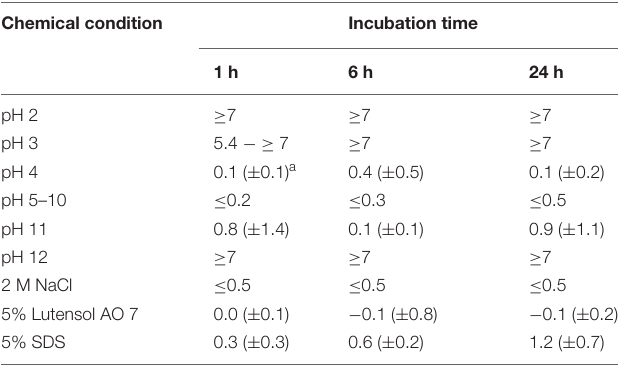
TABLE 1 | Reduction of infectivity of P100 after incubation in TSB adjusted to different pH values, containing NaCl or detergents. Chemical condition Incubation time